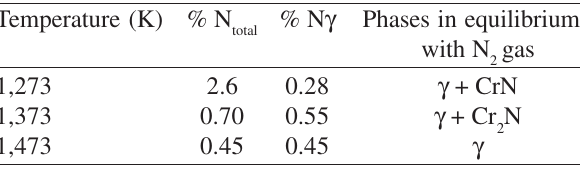
gas in a Fe- 13 %Cr alloy and 0.25 2